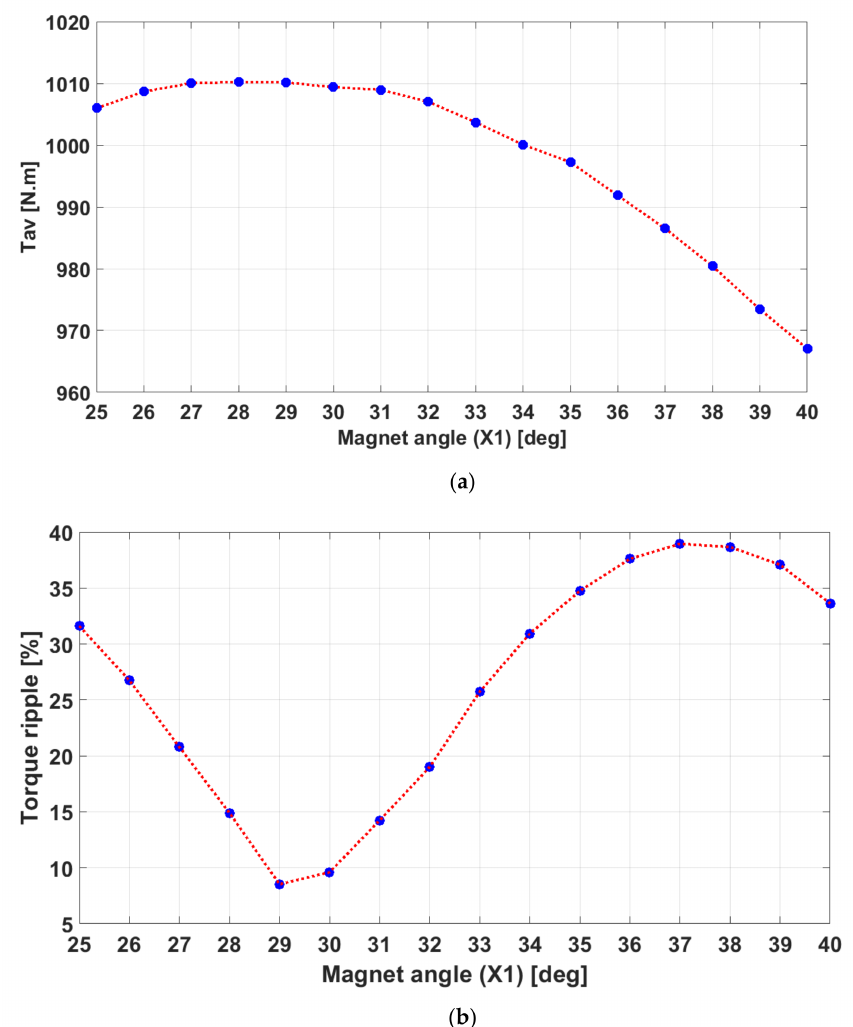
Figure 4. Impact of the side magnet angle variation on: ( a ) the average torque; ( b ) the torque ripple.